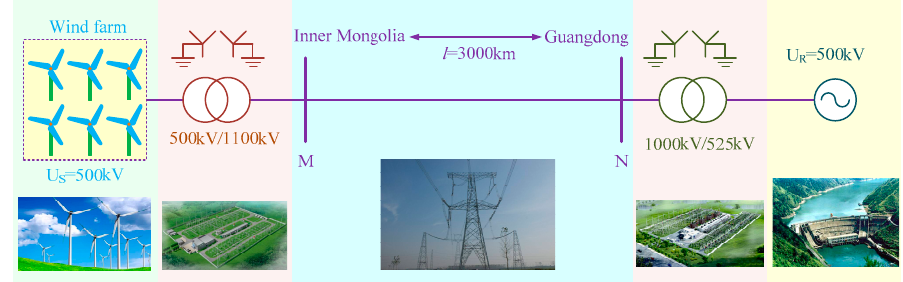
Figure 5. Schematic diagram of the simulation model.